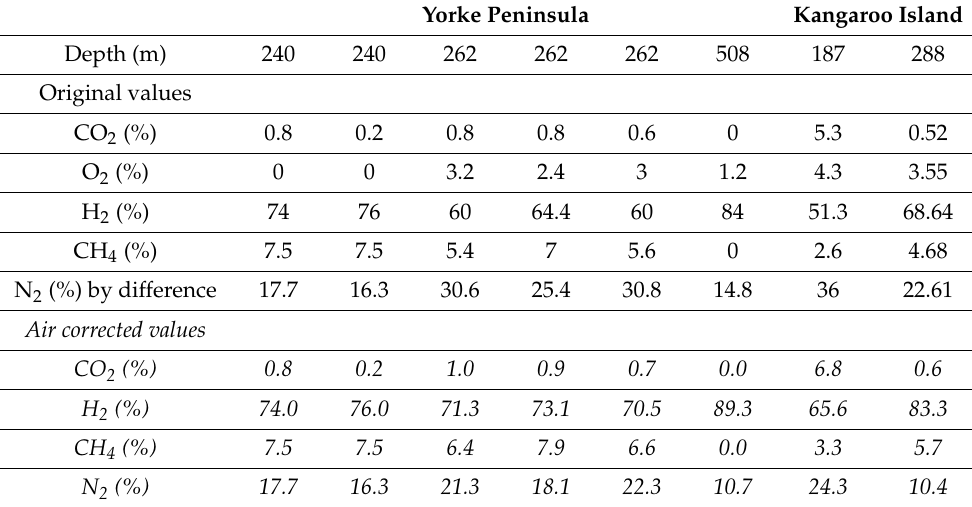
Table 2. Gas analyses from the test of the wells) [47], CO and ethylene have been also measured, their concentration is null. In italic: same analyses, after our correction of air contamination, assuming the standard atmospheric ratio O 2 /N 2 for the air fraction of the analyzed gases and considering, as usual, that all the oxygen come from the air and that the only contamination is atmospheric. Yorke Peninsula Kangaroo Island Depth (m) 240 240 262 262 262 508 187 288 Original values CO 2 (%)